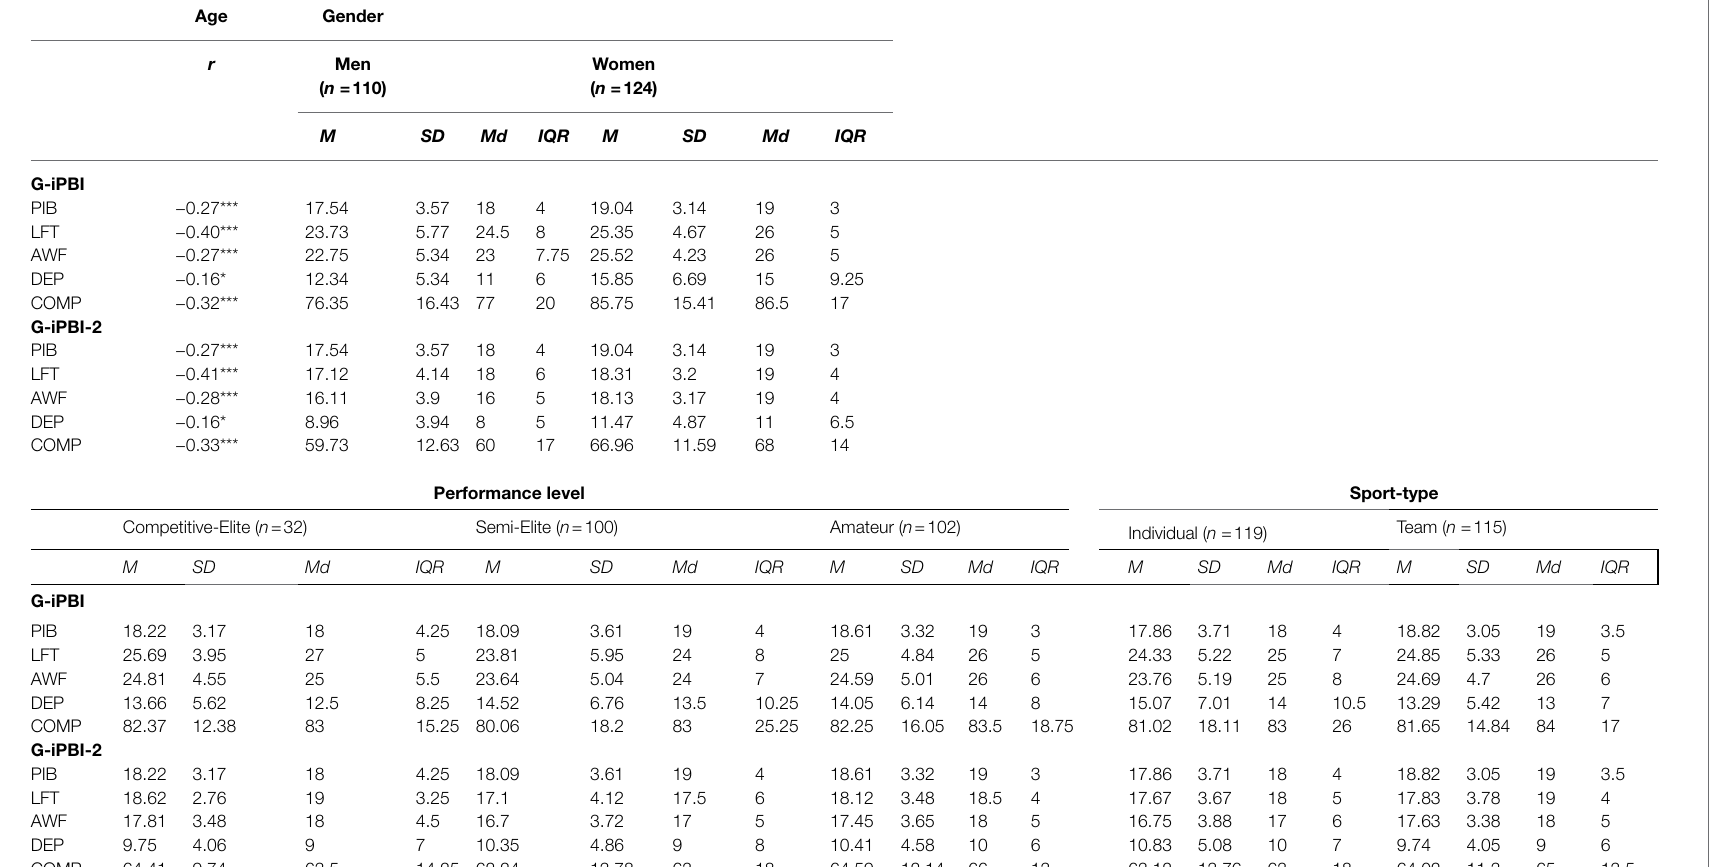
TABLE 4 | Effect size differences between subgroups and bivariate correlations with participant age for the irrational beliefs’ dimensions. Age